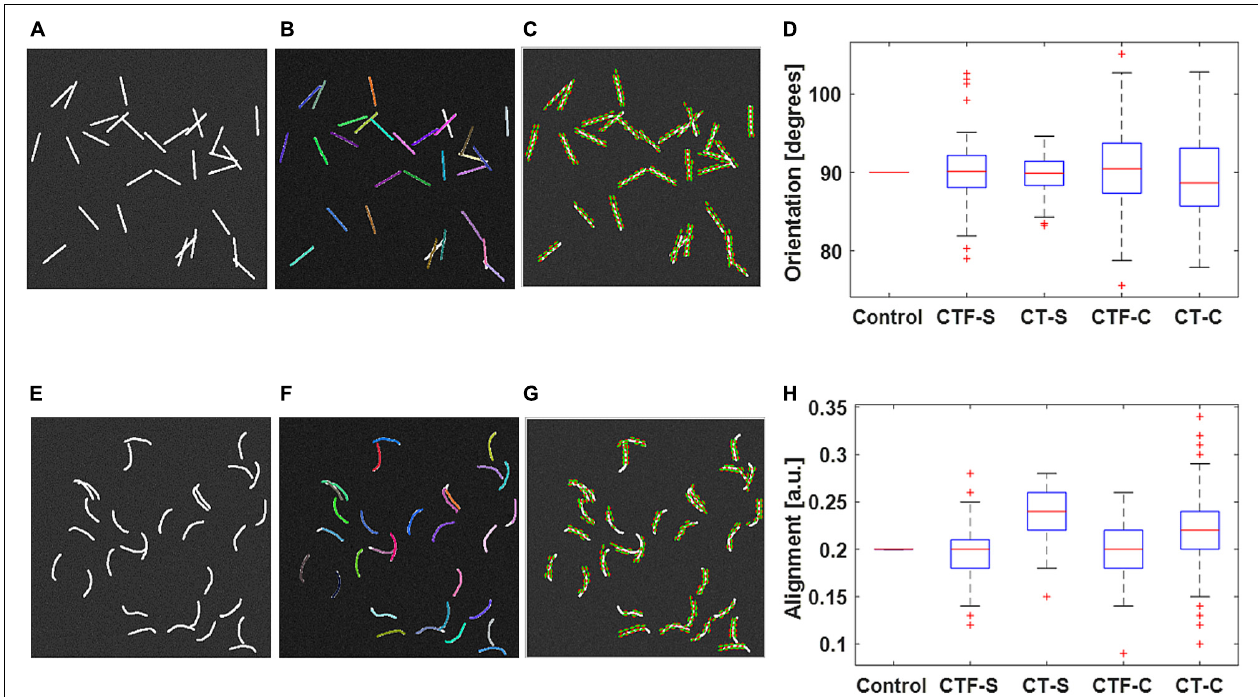
FIGURE 1 | Validation of individual fiber tracking and orientation detection. (A) shows the 30 straight fibers with given fiber properties. (B) CT-FIRE individual fiber overlay image of (A) . (C) CurveAlign CT-curvelets overlay image of (A) . (E) shows the 30 curvy fibers with given fiber properties. (F) CT-FIRE individual fiber overlay image of (E) ; CurveAlign CT-curvelets overlay image of (A) . Both CT-FIRE fibers [color lines in (B) and (F) ] and curvelets [green lines with red center point in (C) and (G) ] are mostly faithfully overlaid on the actual fiber directions. The box plots of average orientation and alignment of the 100 synthetic images in each dataset are shown in (D) and (H) , respectively. The box plots (D) and (H) of the 100 synthetic images in each dataset show that the calculated orientations and alignment are close to the setting parameters. In the boxplot, the red line represents the median; the blue lines represent the 25th and 75th percentiles, respectively; the dashed lines and black lines indicate the lower and upper limits of the data points that are not considered as outliers; and the red crosses represent outliers. The t test shows that all the analysis modes yield the same mean values as the control values for both orientation and alignment at the 5% significance level except for the alignment calculated under the CT mode. CTF-S, CT-FIRE individual fiber mode for straight fiber images; CT-S, CT-curvelets mode for straight fiber images; CTF-C, CT-FIRE individual fiber mode for curvy fiber images; CT-C, CT-curvelets mode for curvy fiber